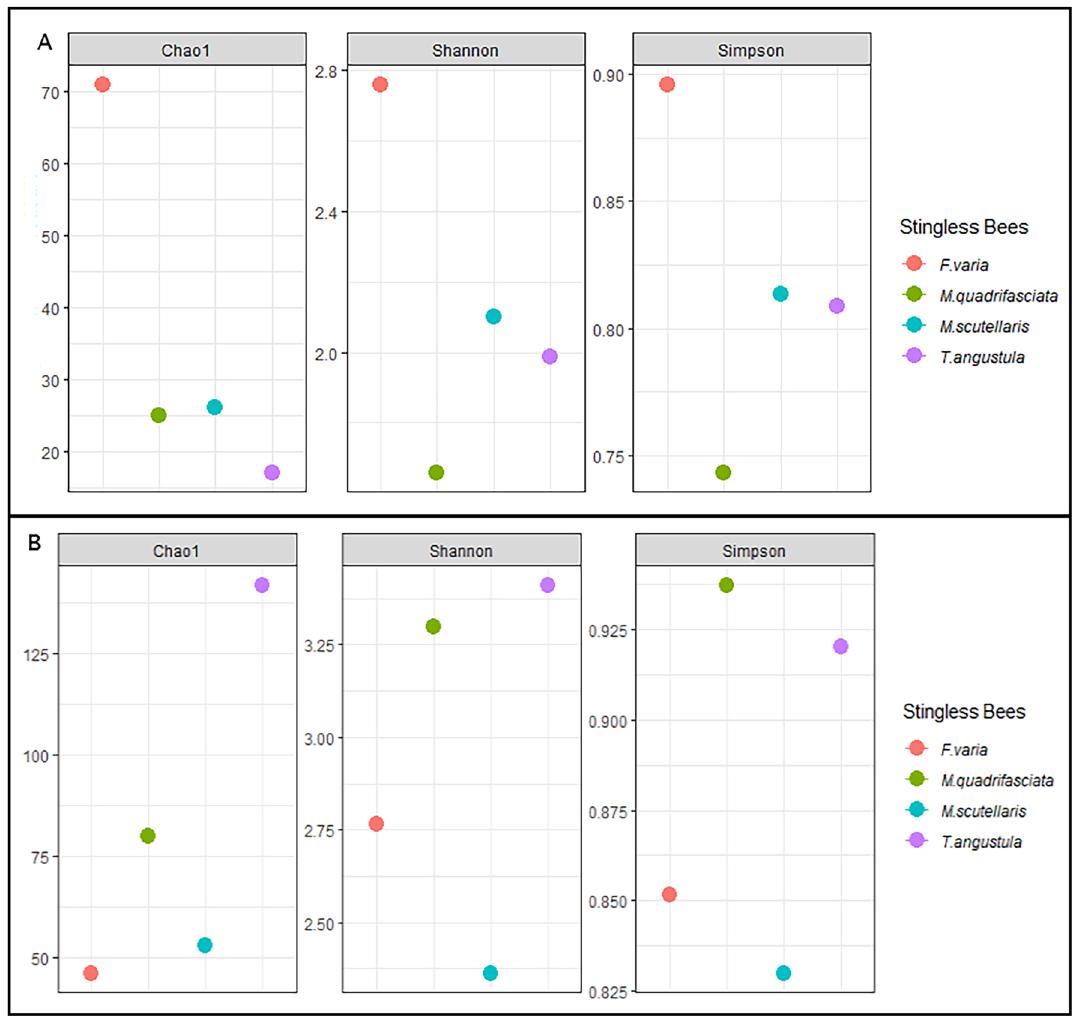
Figure 3. Alpha diversity index generated from the data of Bacterial ( A ) and Fungal ( B ) community